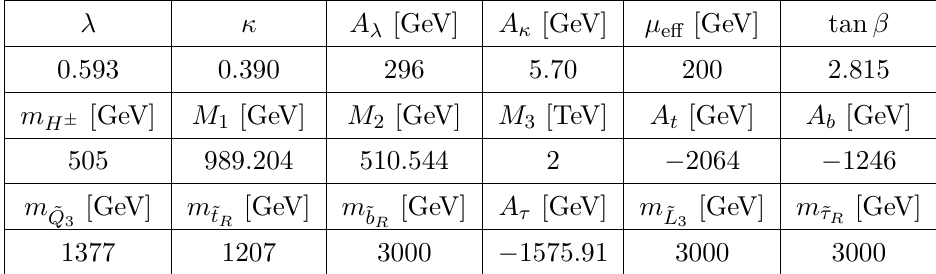
Table 33 . BP16 NMSSM input parameters required by NMSSMCALC for the computation of the NMSSM